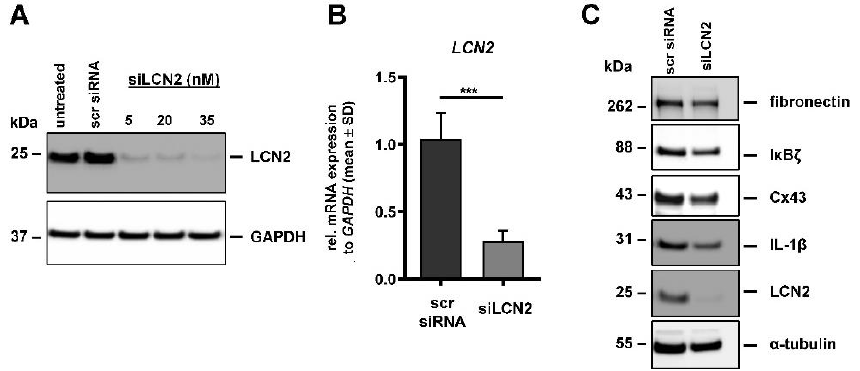
Figure 1. LCN2 and other tumorigenic markers in human prostate cancer cell lines. The human prostate cancer cell lines LNCaP and PC-3 were analyzed for mRNA or protein expression after culturing under basal conditions. ( A ) Quantitative mRNA analysis of NFKBIZ, GJA1, IL1B, LCN2, and CXCL8 in both cell lines revealed significantly higher expression levels in PC-3 cells (n = 4). Relative mRNA expressions were normalized to ACTB expression and values are given in relation to LNCaP cells. Significant differences between LNCaP and PC-3 cells are indicated as *** p < 0.001. ( B ) Western blot analysis confirmed lower protein expression of these markers in LNCaP cells (n ≥ 3). β-actin and α-tubulin expression served as internal loading controls.